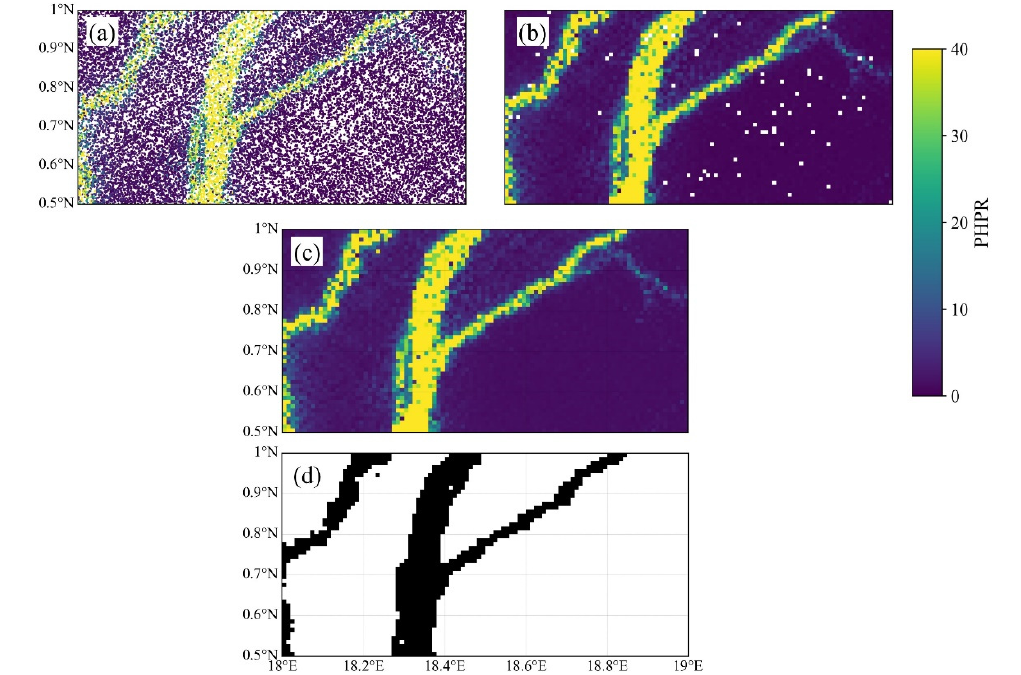
Figure 9. Example generation of PHPR water mask. ( a ) PHPR at specular reflection points. ( b ) Gridded PHPR with a spatial resolution of 0.01°. ( c ) PHPR map with empty grid cells filled through nearest neighbor interpolation. ( d ) PHPR water mask obtained by random walker segmentation with water bodies marked with black color.